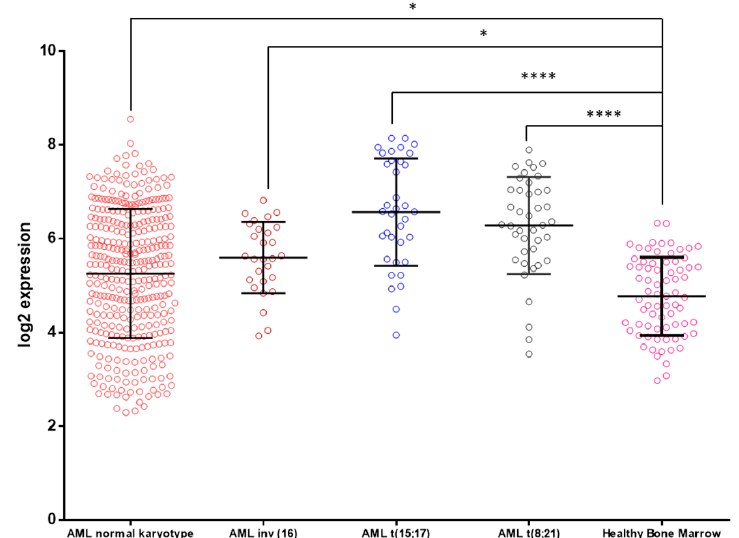
Figure 4. KCTD15 expression in human AML samples. Microarray data of KCTD15 were obtained from the MILE study dataset (accession number GEO13159) and plotted as log2 transformed expression values. AML samples were classified as AML normal karyotype (mean = 5.26, SD = 1.38, n = 351 samples, red circles), AML inv (16) (mean = 5.60, SD = 0.75, n = 28 samples, Bordeaux circles), AML t(15;17) (mean = 6.57, SD = 1.14, n = 36 samples, blue circles), AML t(8;21) (mean = 6.28, SD = 1.03, n = 41 samples, black circles), and healthy bone marrow (mean = 4.77, SD = 0.83, n = 73 samples, pink circles). One-way ANOVA with Bonferroni’s multiple comparison test was applied; **** p < 0.0001, * p < 0.05.